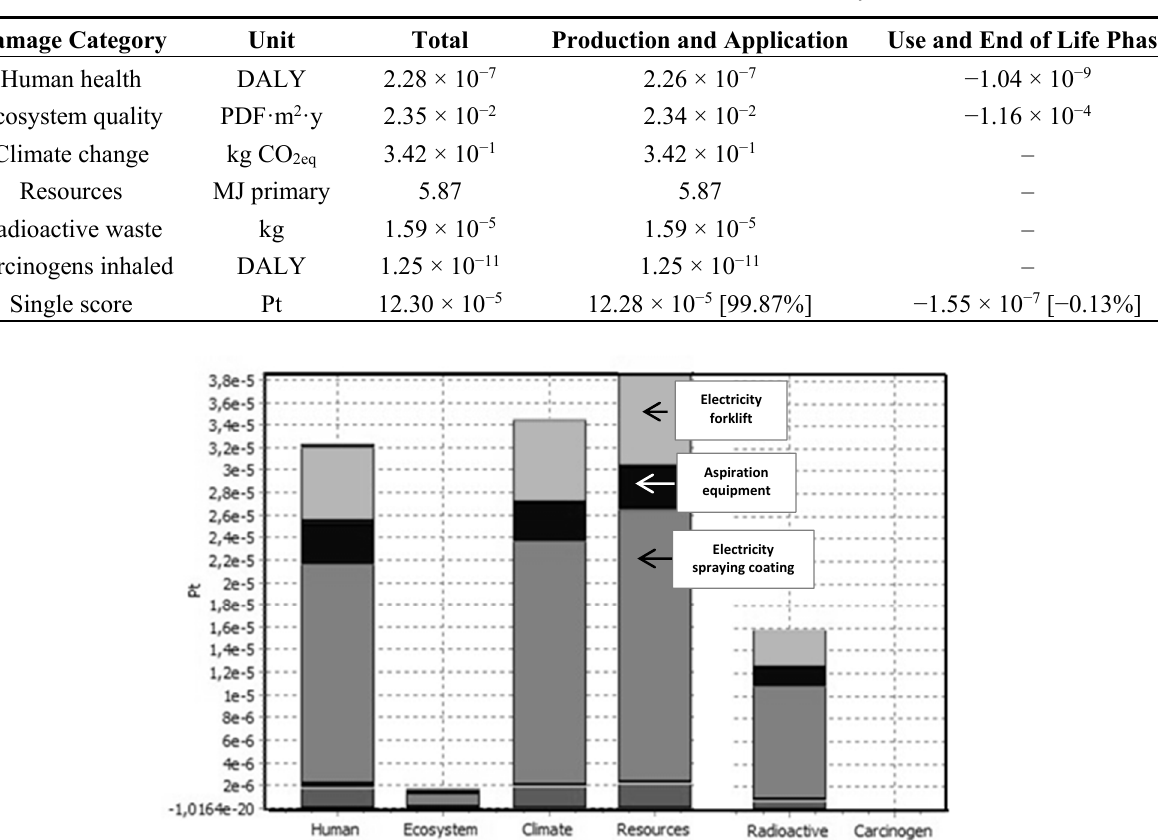
Table 3. Characterization and evaluation of the life cycle.